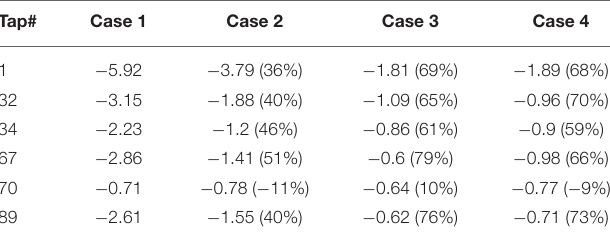
TABLE 2 | C p min for selected taps at the wind direction of 45